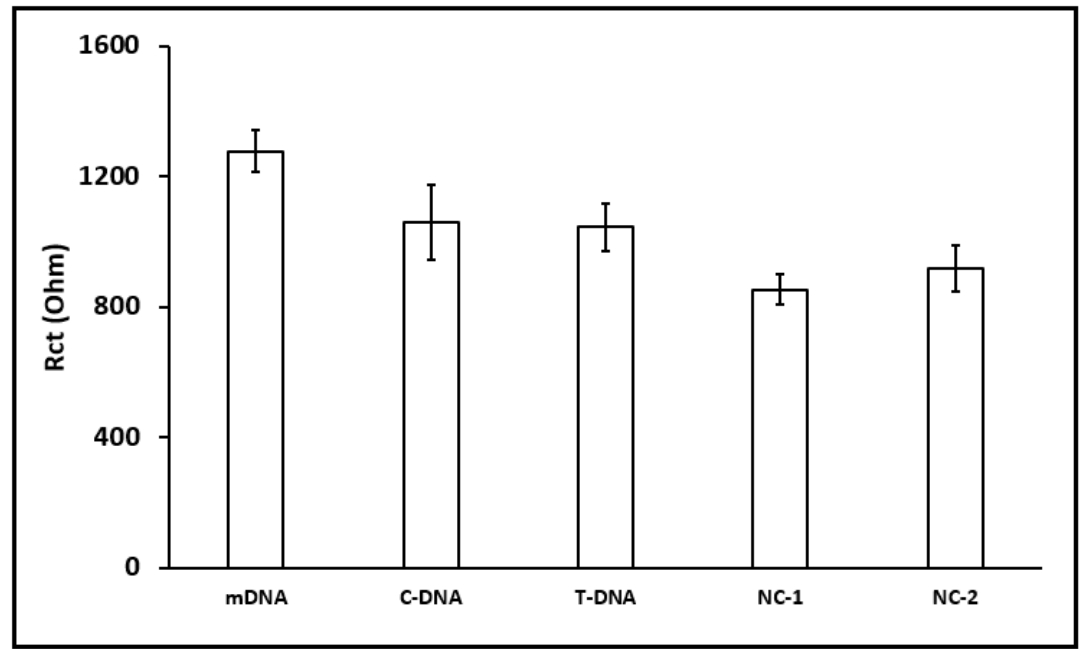
Figure 6. Histograms representing the average R ct values related to the hybridization of ZNA probe with mDNA target, C-DNA, T-DNA, NC-1 or NC-2 ( n = 3).